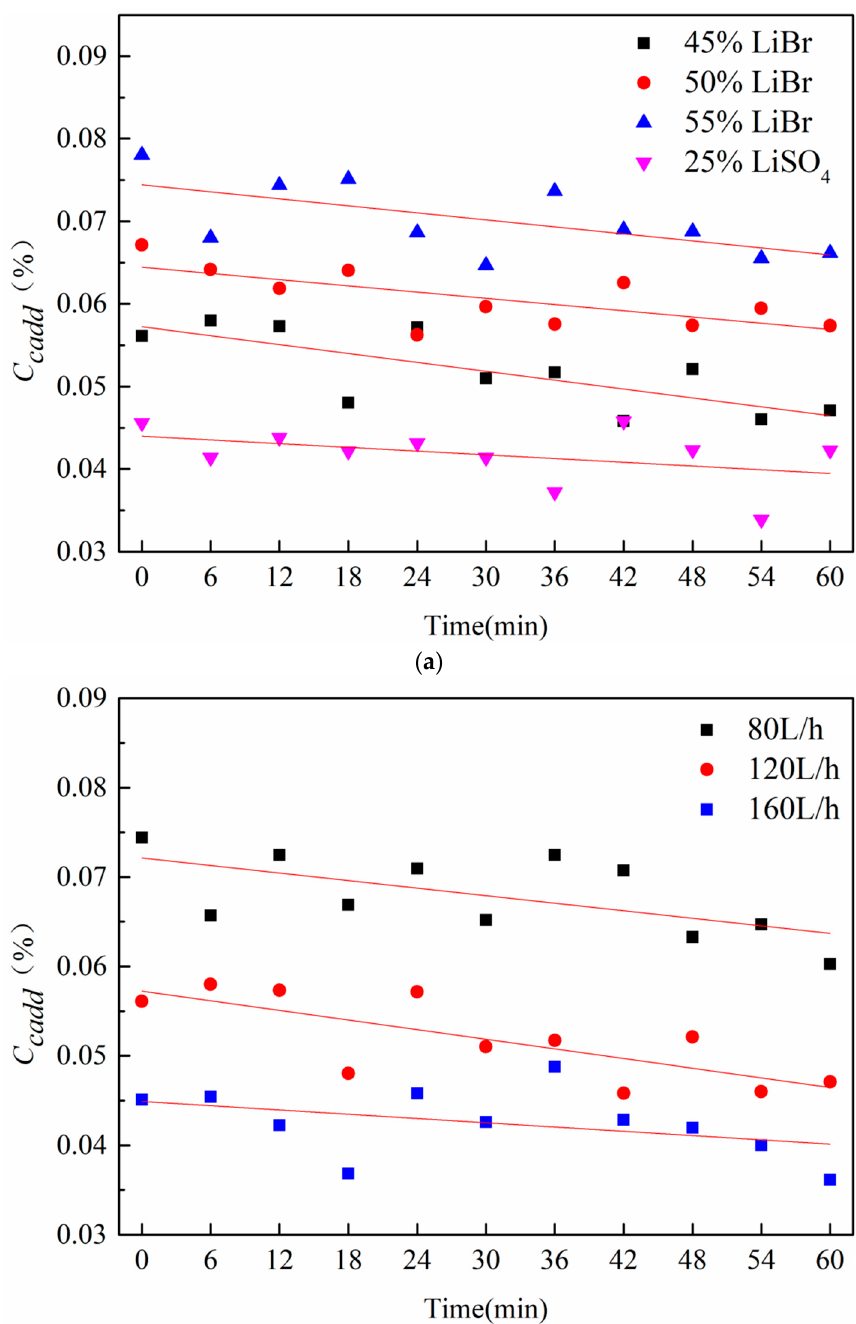
Figure 6. The effect of electrode solution. ( a ) The effect of concentration of electrode solution. ( b ) The Figure 6. The e ff ect of electrode solution. ( a ) The e ff ect of concentration of electrode solution. ( b ) The effect of flow rate of electrode solution. e ff ect of flow rate of electrode